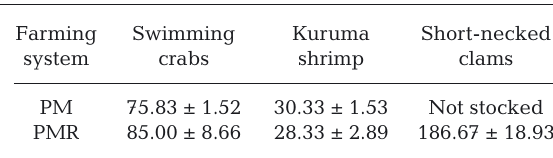
Table 1. Yield information (g m −2 ) of animals cultured in 2 polyculture systems. PM: Swimming crabs with kuruma shrimp; PMR: swimming crabs with